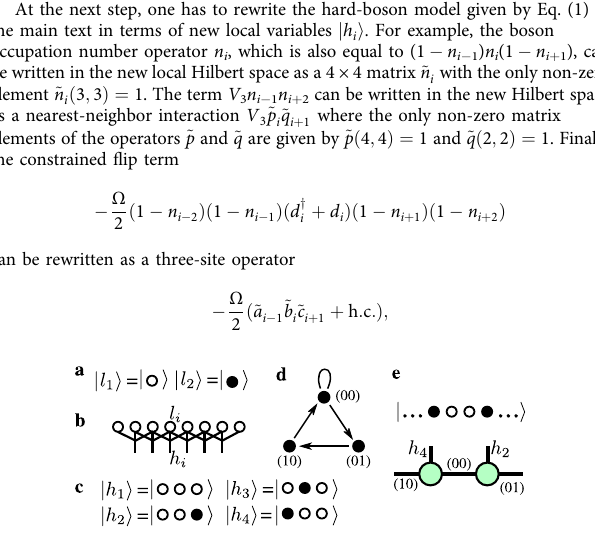
Fig. 7 Rigorous mapping onto a model that preserves the block-diagonal structure of tensors. a Local Hilbert space of the original model l i open ( fi lled) circle stands for an empty (occupied) site. b Rigorous mapping onto a model with a local Hilbert space spanned over three consecutive hard bosons that consist of four states sketched in c . The index of the new site corresponds to the index of the middle site. d Fusion graph for the recursive construction of the left environment; for the right environment the direction of the arrows should be inverted. e Example of the label assignment in MPS representation on two consecutive tensors (green circles) written for the selected